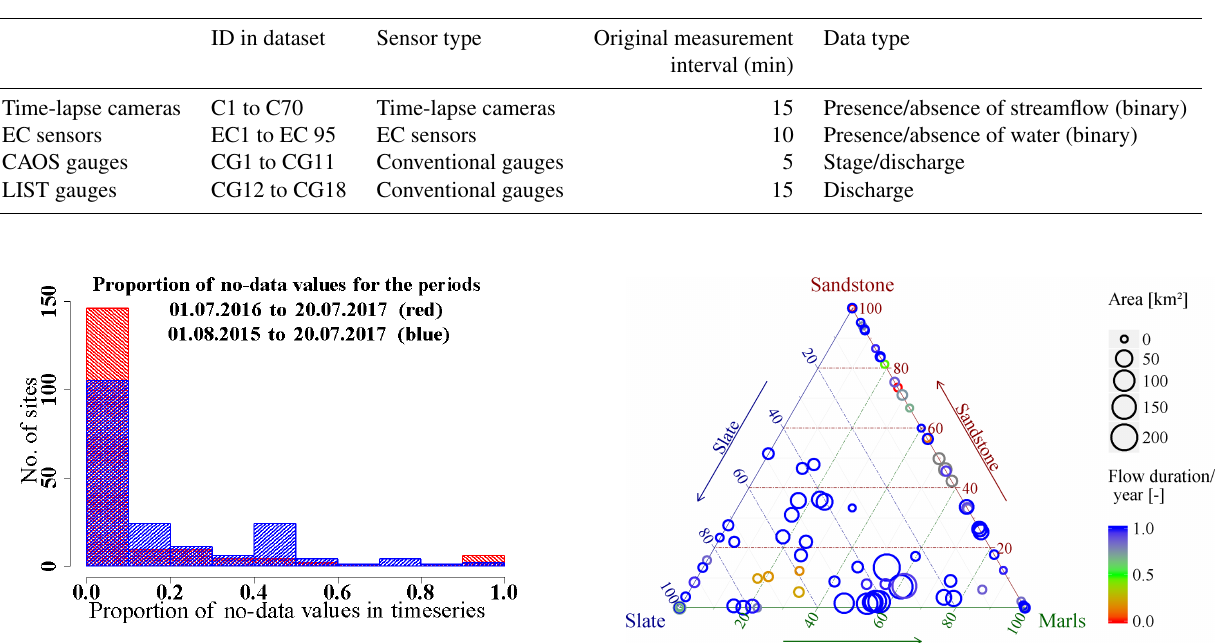
Table 1. Overview of sensors included in the streamflow dataset.